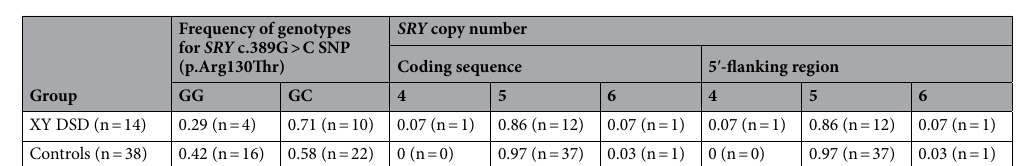
Figure 3. Characteristics of DSD case #7513: ( a, b, c ) ambiguous external genitalia: rudimentary penis and vulva; ( d ) histology of gonads: testes with sparse seminiferous tubules, hypertrophic Sertoli cells, numerous Leydig cells and lack of germinal epithelial cells; FISH with X (red) and Y (green) chromosome painting probes showing two cell lines: 38,XX ( e ) and 38,XY ( f ) in lymphocytes; ( g ) estimation of the Y/X ratio based on proportion of AMELY and AMELX genes in blood leukocytes (#7513B) and fibroblasts (#7513F). The upper chart shows amplification signals from chromosome X (green color) and Y (blue color). In fibroblasts of case #7513 (#7513F) the signal was detected from chromosome X only. Both signals were detected in blood leukocytes (#7513B). On the lower chart, an Y/X ratio of approximately 0.5 was detected in blood leukocytes (#7513B), indicating the presence of two cell lines. In fibroblasts of DSD case #7513 (#7513F) and in a control female (FM), the lack of Y chromosome resulted in a Y/X ratio of = 0, while a Y/X ratio of approximately 1 was detected in a control male (M); NC: negative control.